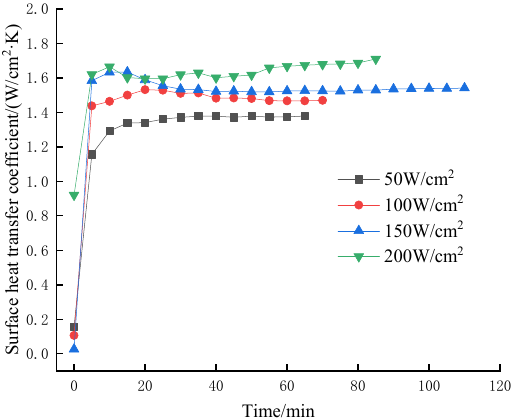
Figure 4. Transient surface heat transfer coefficient with change of heat flux at a flow rate of 40 L/h.